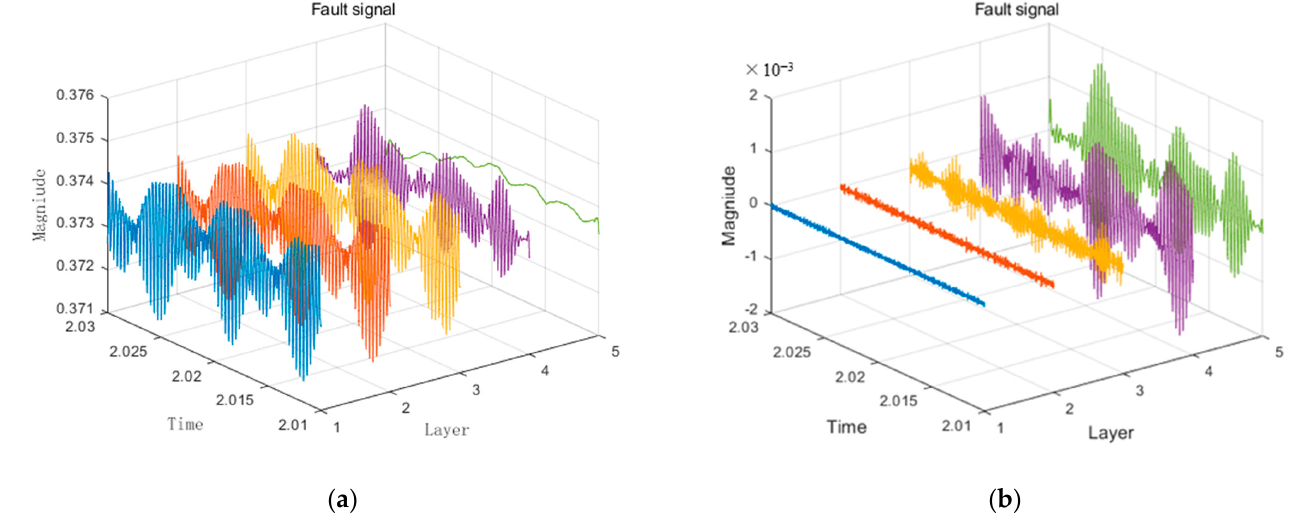
Figure 8. Wavelet decomposition diagram of the fault current: ( a ) approximation coefficients; ( b ) detail coefficients.